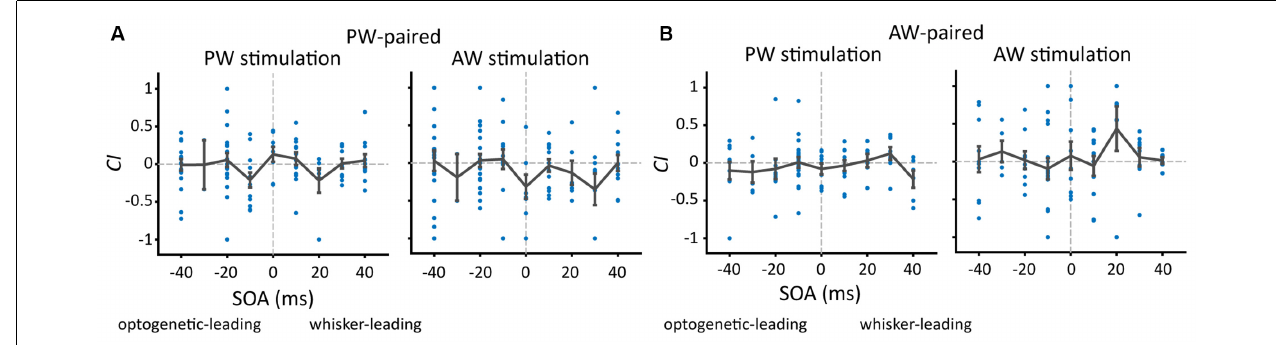
FIGURE 4 | The proportion of units showing a change after paired stimulation and the change in CI s (Change Index) as a function of SOA. (A) After PW-paired stimulation, CI s in PW or AW were not altered ( p > 0.05/9 in all conditions, Wilcoxon signed-rank test, Bonferroni correction) across a variety of SOAs. Each data point represents CI in the paired direction of every single unit. The error bar represents the mean ± s.e.m. (B) After AW-paired stimulation, CI s for PW or AW were not altered ( p > 0.05/9 in all